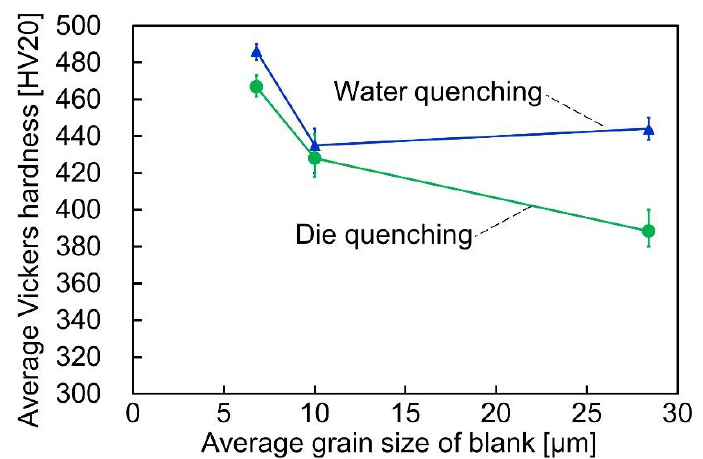
Figure 11. Effect of average grain size of blank on Vickers hardness after die- and water-quenching using direct resistance heating for v = 275 °C/s and t = 0 s.